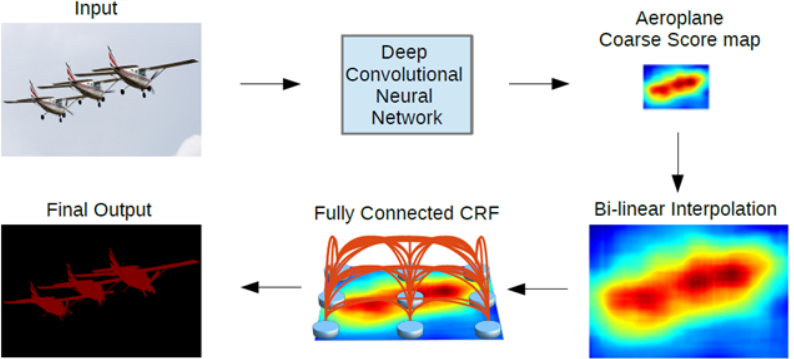
Figure 1. DeepLab V1 network structure .